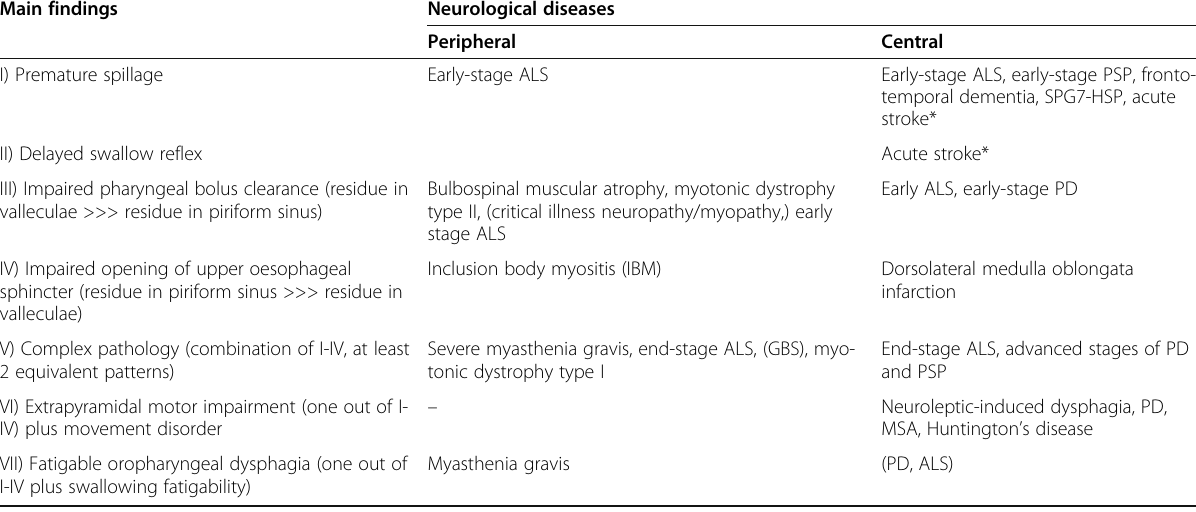
Table 3 Endoscopic phenotypes of neurogenic dysphagia